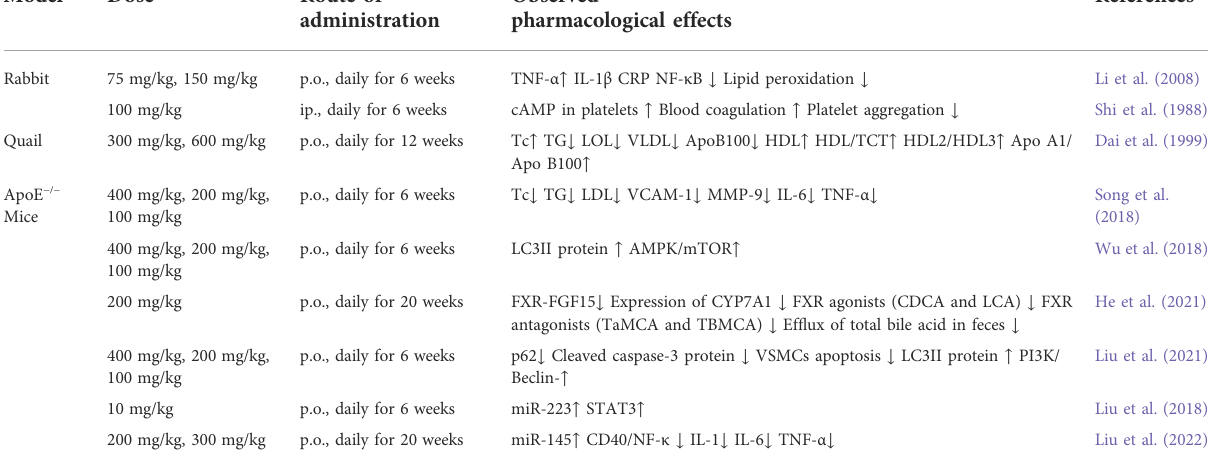
TABLE 1 Anti-atherosclerotic effects of paeonol in different animal models. Model